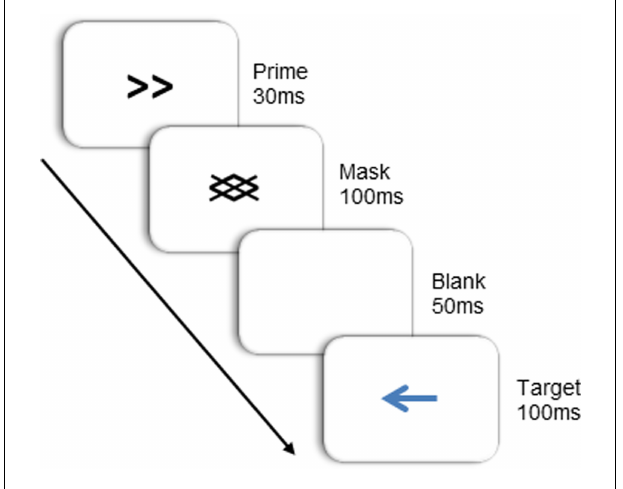
FIGURE 2 | Stimulus and